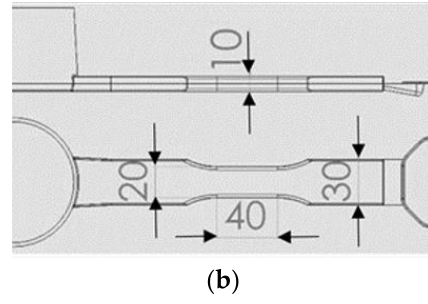
Figure 1. ( a ) Illustration of the SSM casting and ( b ) dimensions in